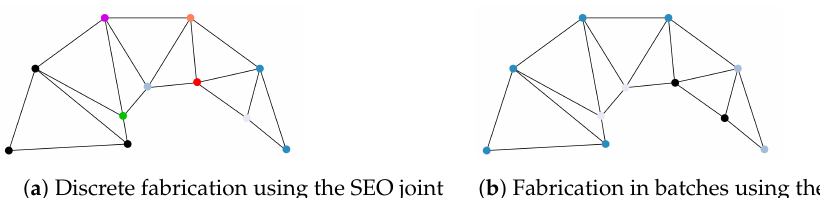
Figure 8. Two options to fabricate the case study joints with a ( a ) discrete fabrication or ( b ) fabrication in batches. The different colours represent joints that belong to different fabrication